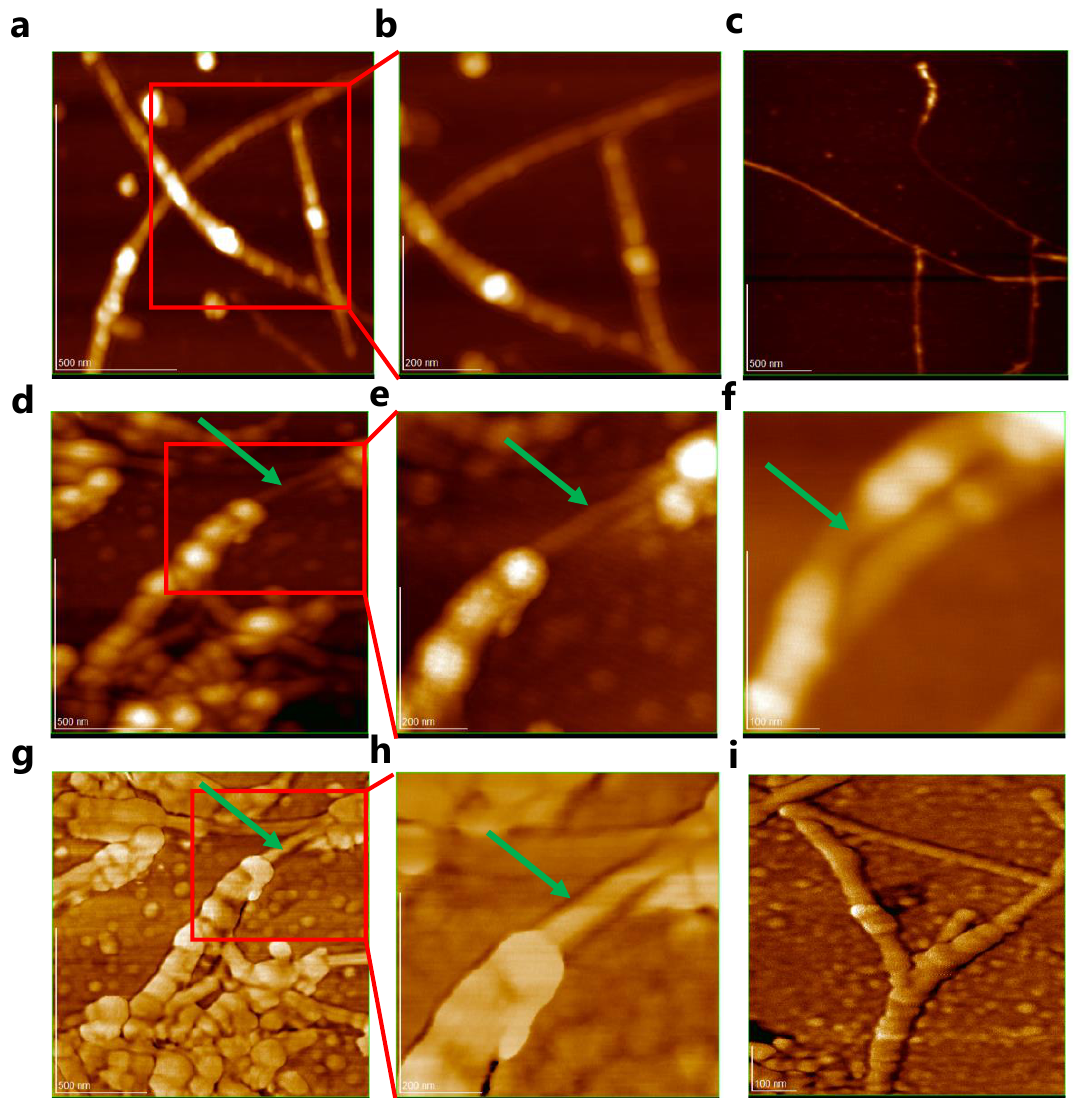
Figure 5. Typical AFM images ( a – f ) (topographic) ( g – i ) (phase) of polymer/SWNT nanocomposite on mica surface collected under ambient conditions. The green arrows in the images ( d – h ) refer to bare SWNT.